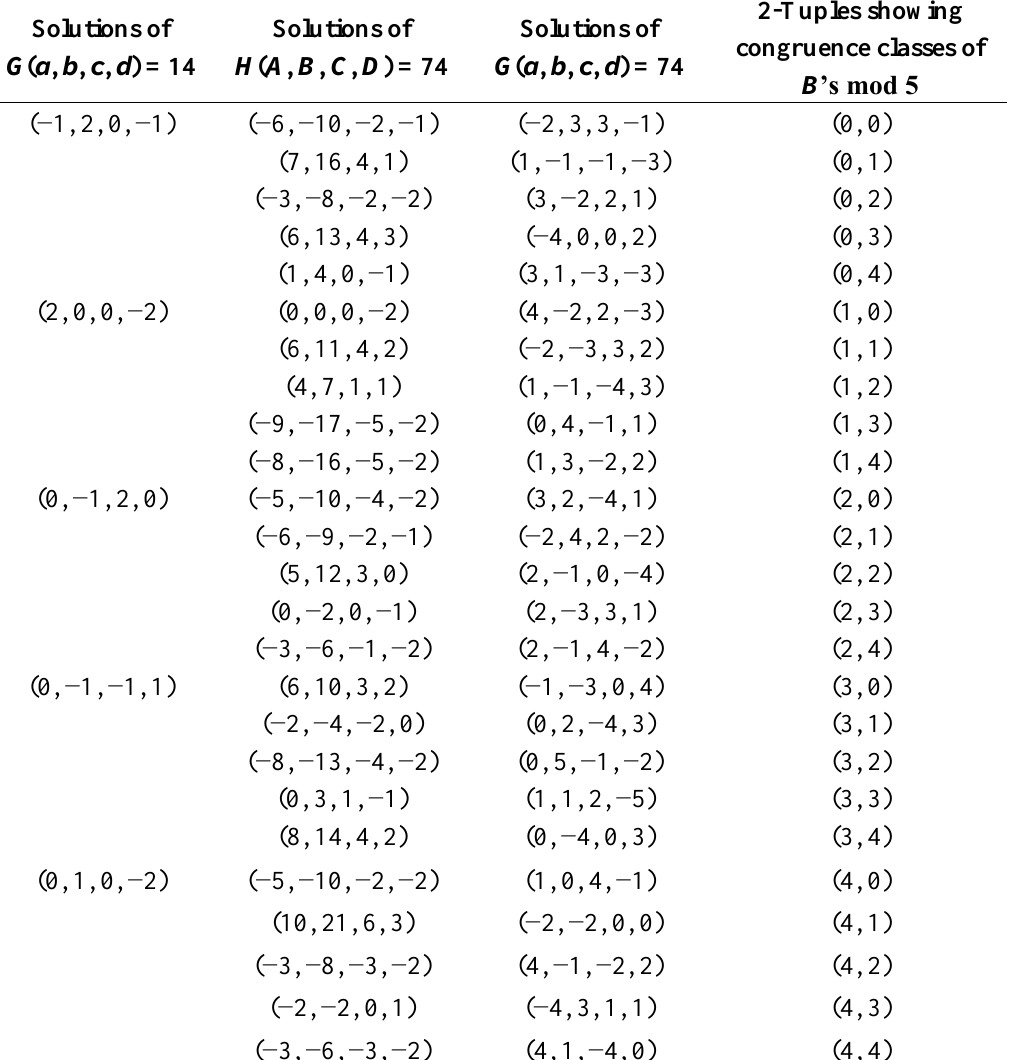
Table 2. Solutions corresponding to 5-cores of